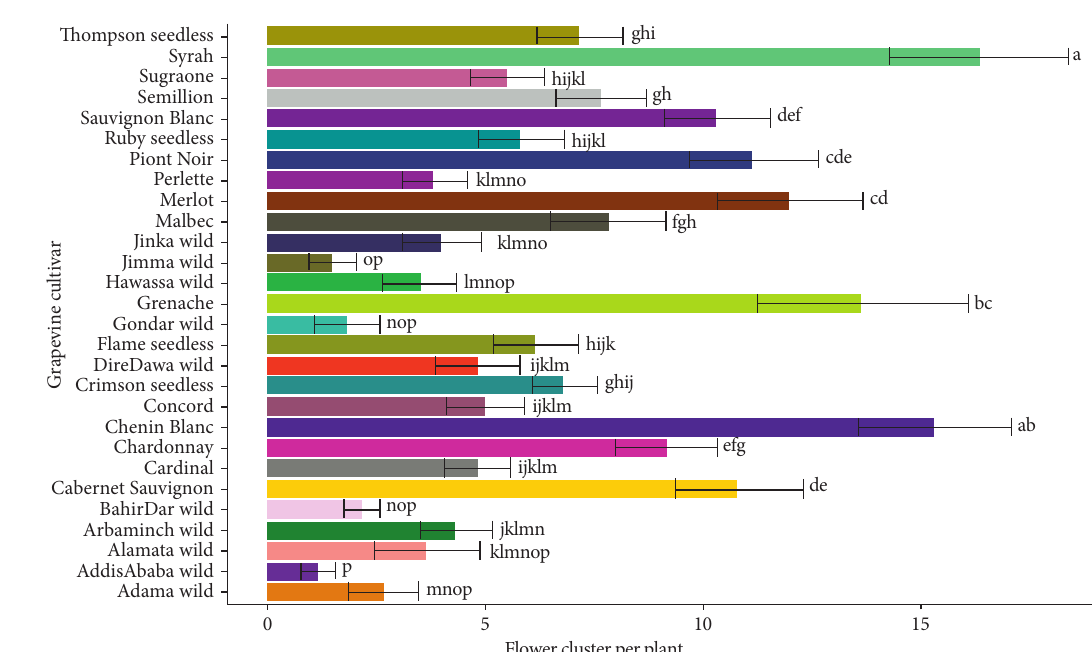
Figure 9: Response of flower cluster number to grapevine